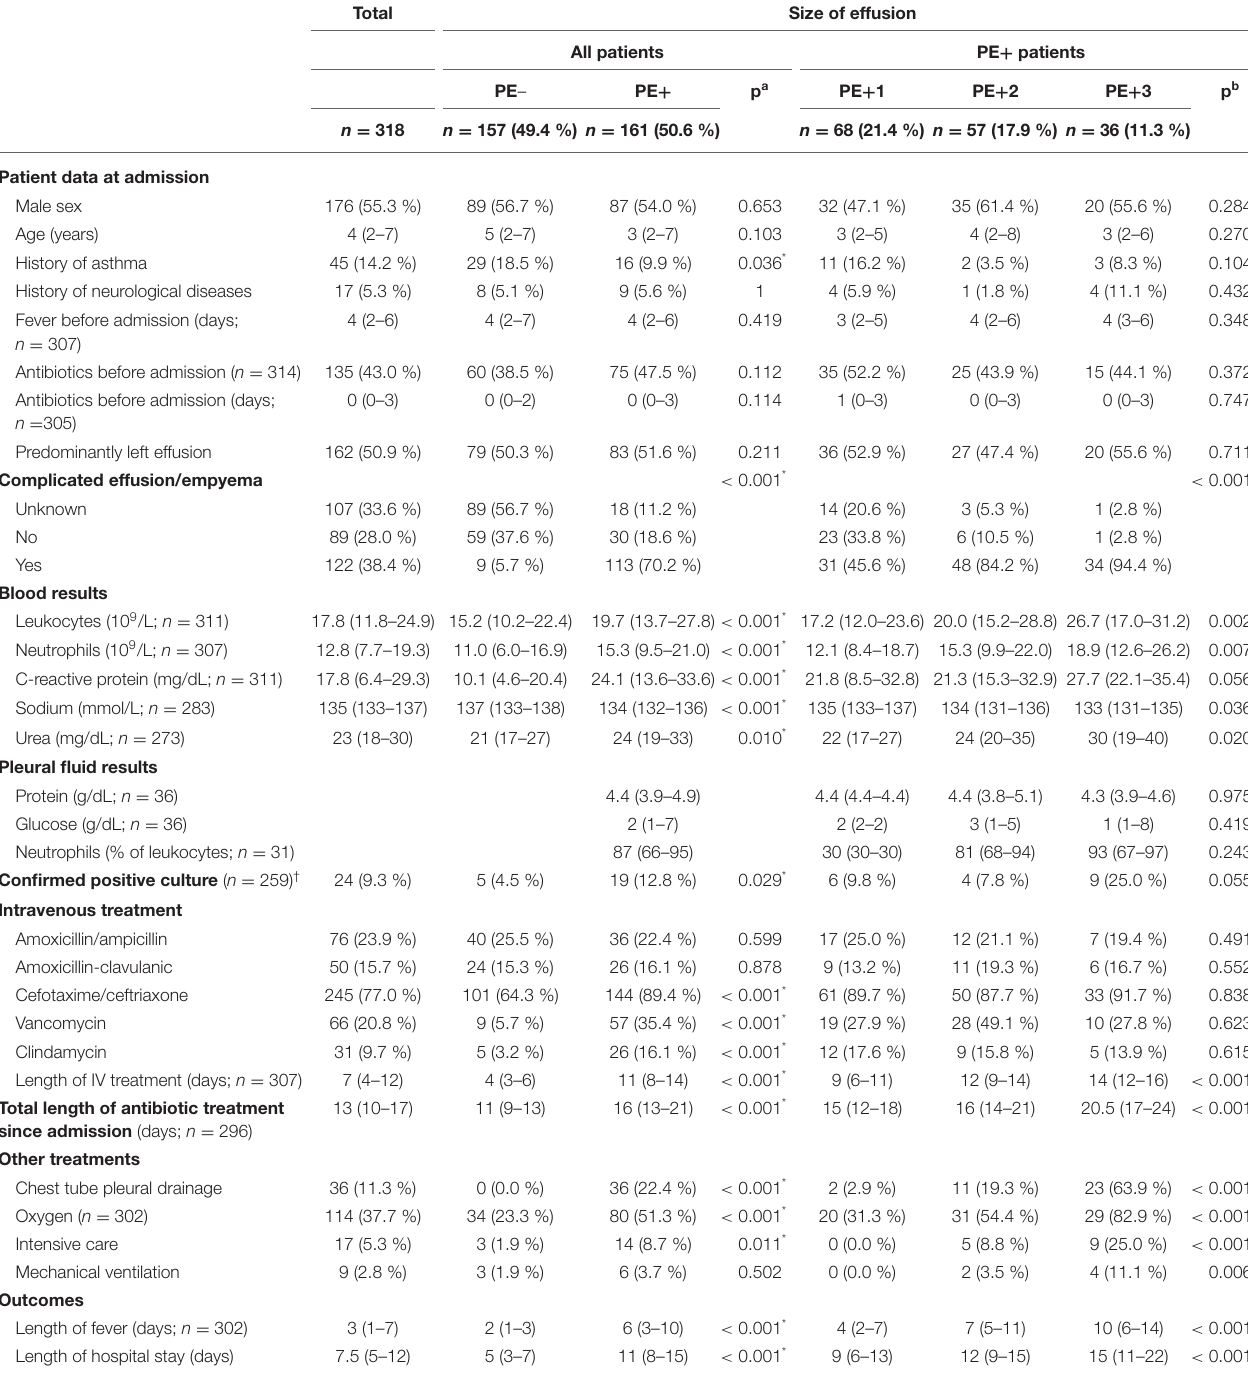
TABLE 1 | Patient characteristics, treatment, and outcomes separated by size of effusion. Total Size of effusion All